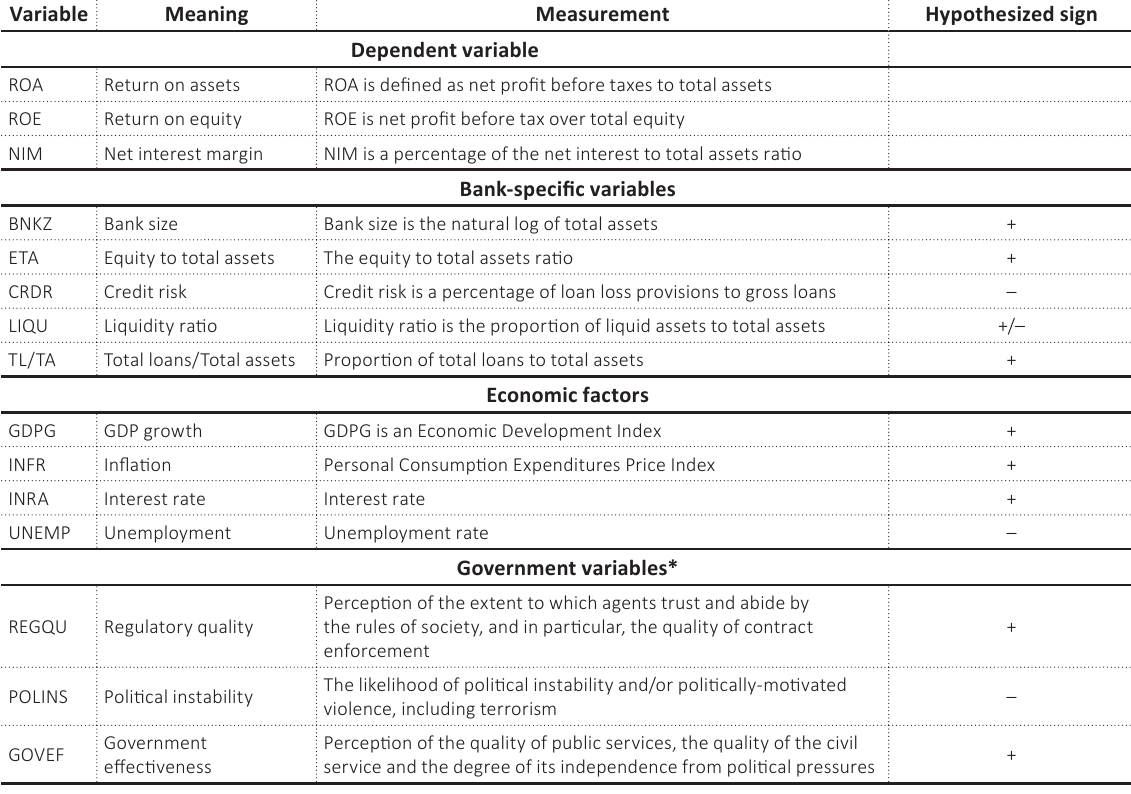
Table 1. Measurement of variables and a predicted